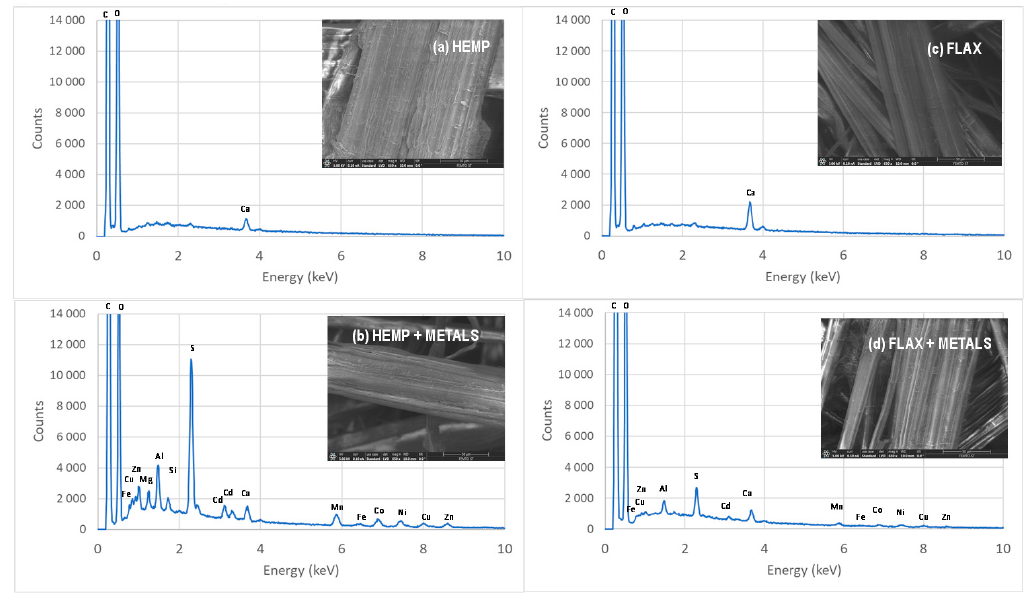
Figure 9. Elemental analysis using energy-dispersive X-ray spectroscopy and scanning electron microscopy images of hemp- and flax-based felts before ( a , c ) and after ( b , d ) adsorption of a solution containing a mixture of seven metals.